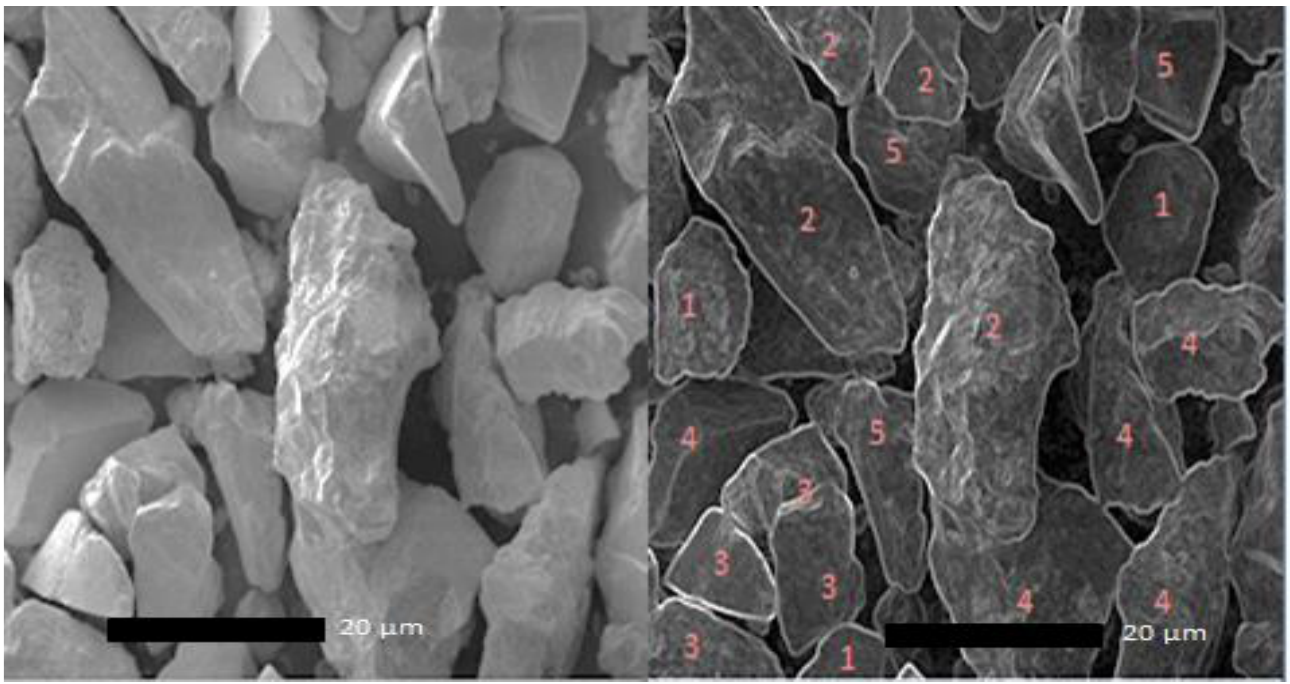
Figure 5. Backscatter electron (BSE) image of the selected sand grains from the mineral fraction with constituents identified through EDS analysis of every single grain. The numbers 1 represent ilmenite, 2 for monazite, 3 for zircon, 4 for titanite, and 5 for magnetite; Scale bar = 20 µm.